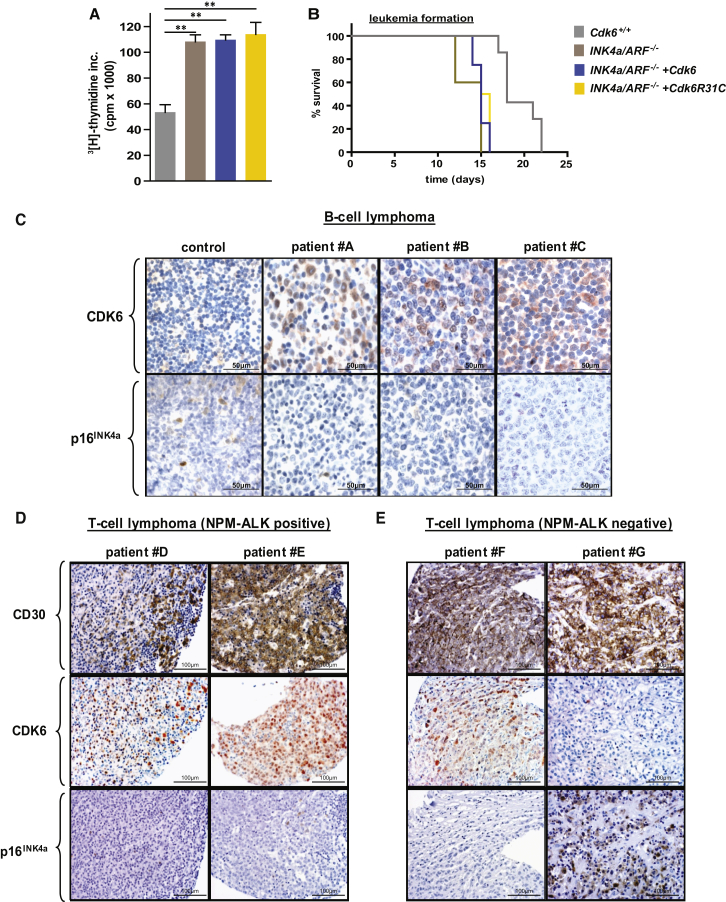
Figure 3. Inverse Relation between CDK6 and p16INK4a Expression in Human Lymphomas